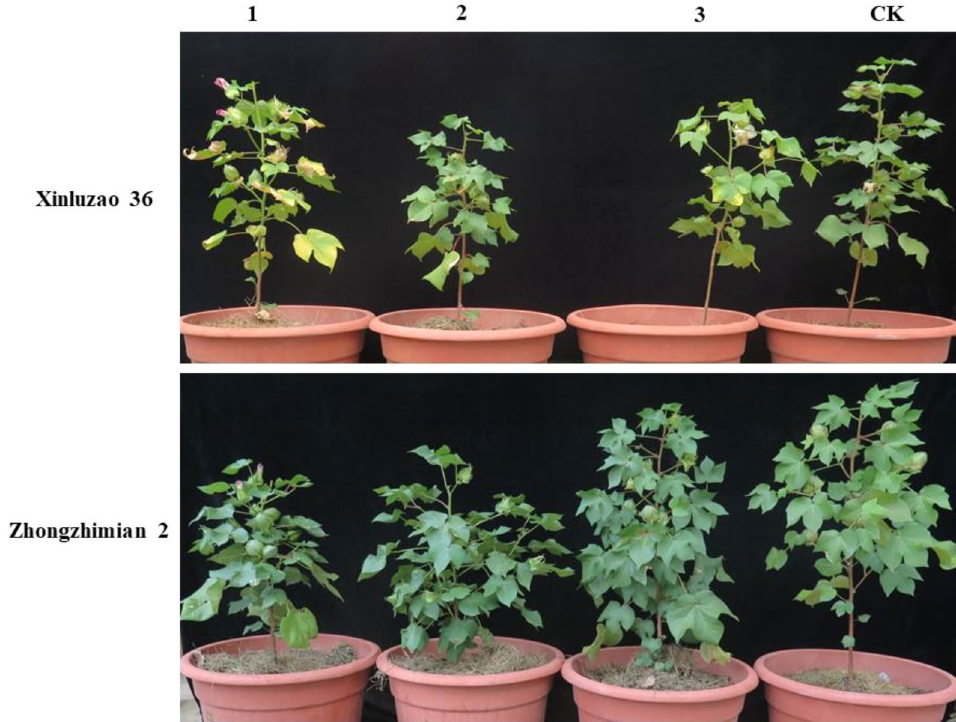
Figure 1. Morphologic and physiologic features of Xinluzao-36 and Zhongzhimian-2 subsequent to V. dahliae fungus